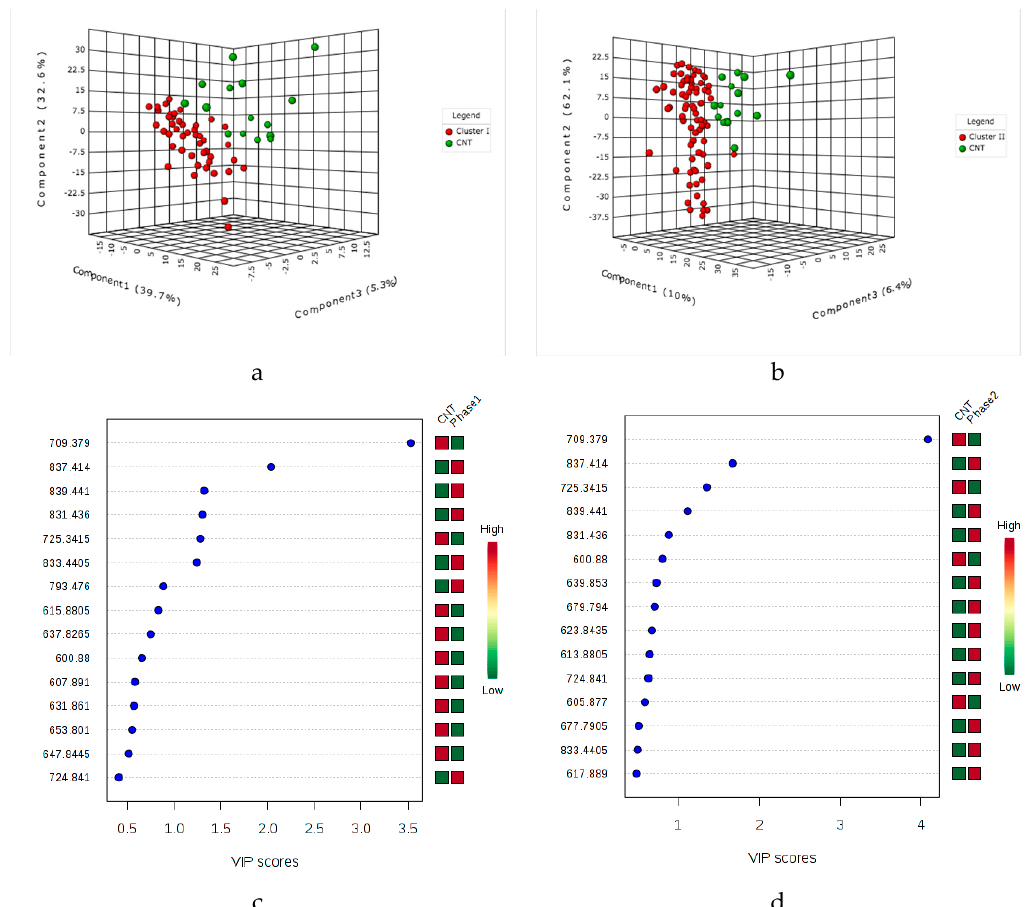
Figure 4. Multivariate partial least squares discriminant analysis applied to the MALDI (+)-MS data: ( a ) Early asymptomatic infection and control and ( b ) Late asymptomatic infection and control. The VIP plots ( c ) Early asymptomatic infection and control and ( d ) Late asymptomatic infection and control.